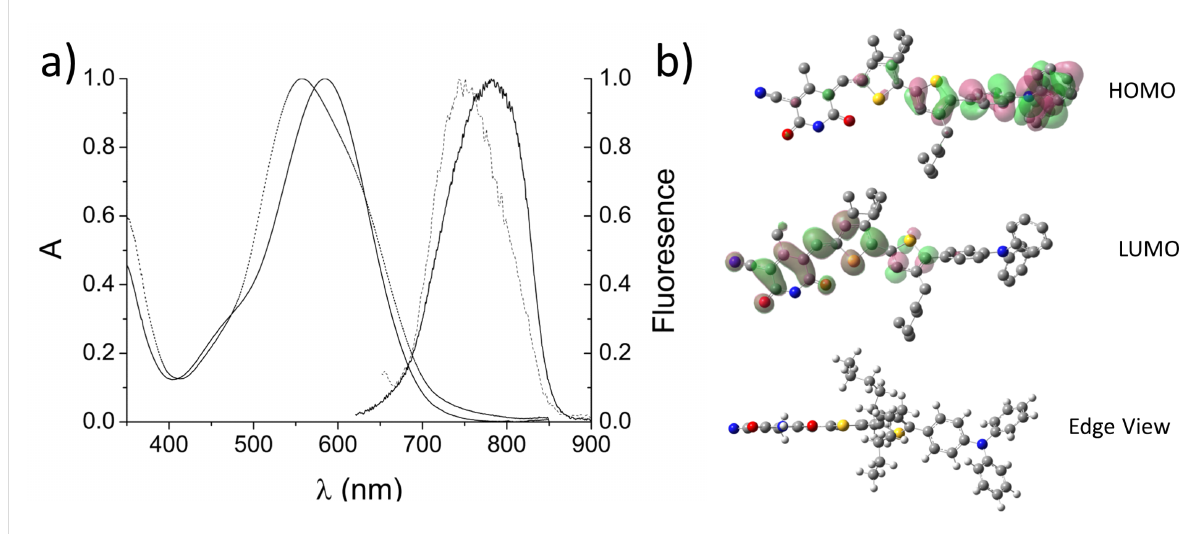
Figure 2: (a) Chloroform (solid line) and thin-film (dashed line) UV–vis absorption and emission spectra and (b) optimized DFT structure and calcu- lated orbital densities of compound 2 .